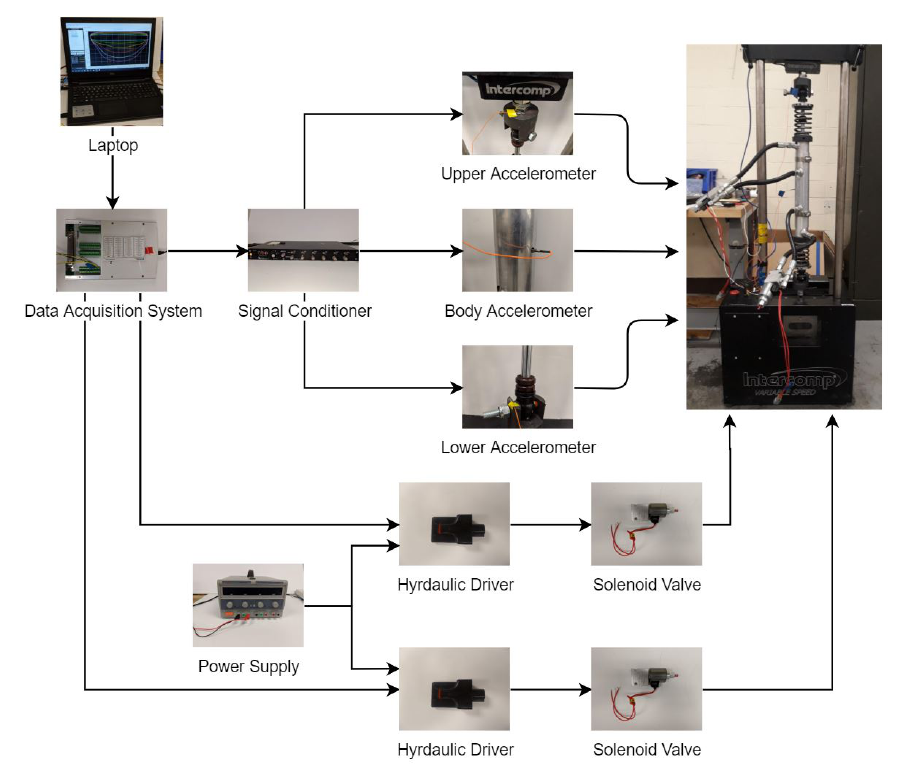
Figure 4. Assembly of Hardware Implementation.